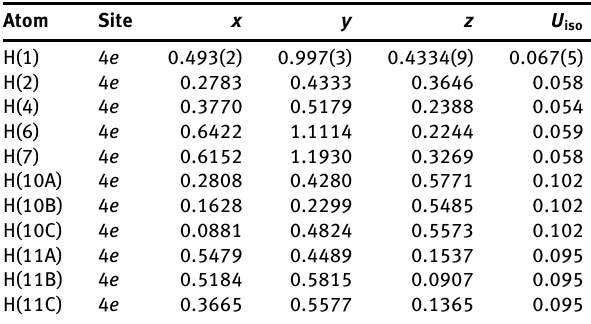
Table 2: Fractional atomic coordinates and isotropic or equivalent isotropic displacement parameters (Å 2